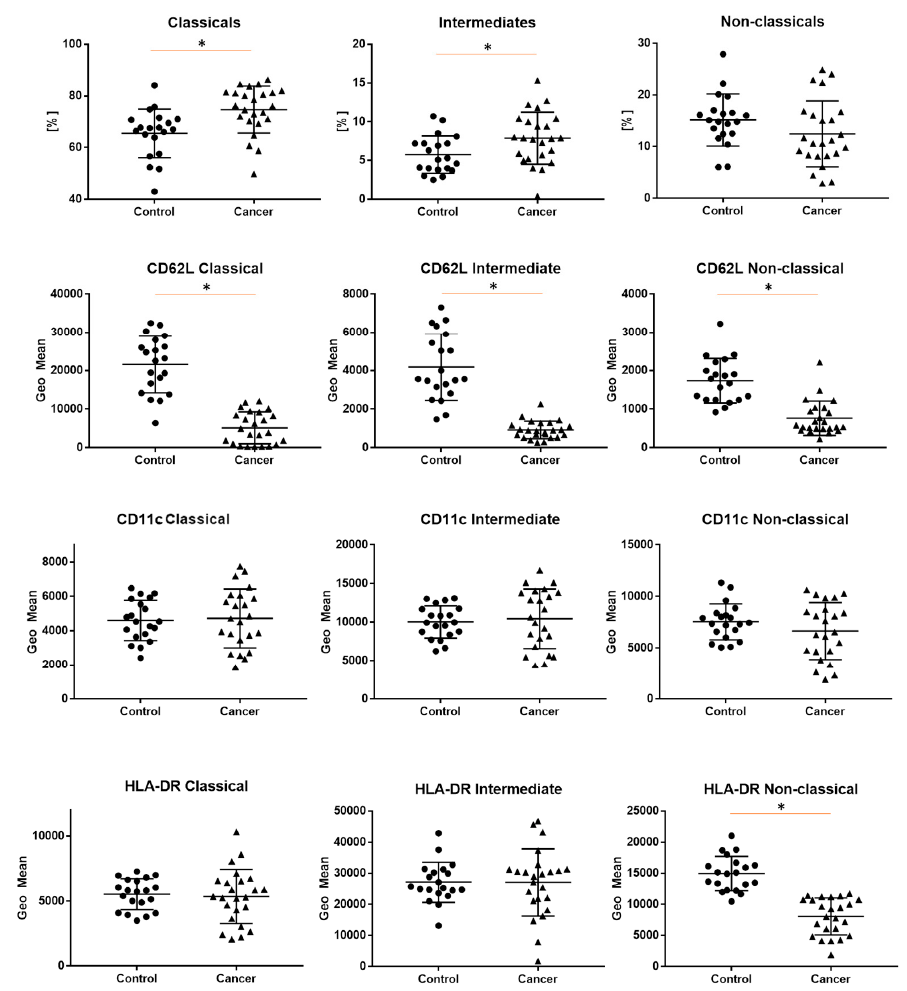
Figure 3. The differences between cancer group and study group for geometric means expression of CD62L, CD11c and HLA-DR on classical, intermediate, and non-classical monocytes. Graphs show the median values and quartile Q1–Q3 * p < 0.05.